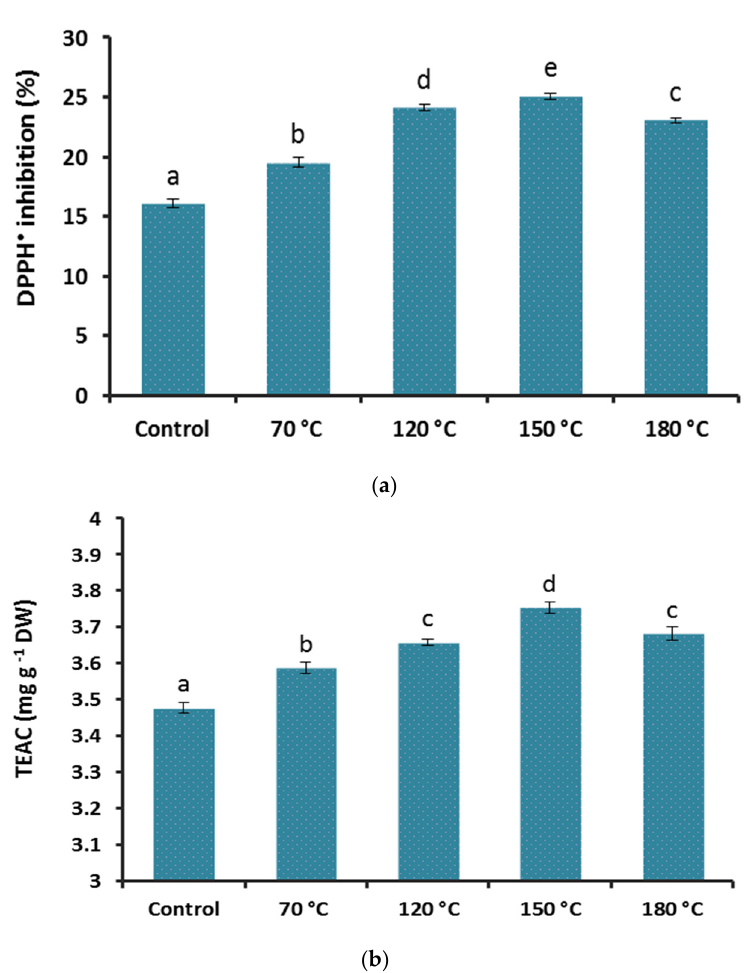
Figure 3. The antioxidant capacity (mean ± StDev) of ( G. lingzhi ) basidiocarp extract (2.5 mg mL − 1 ) after heat treatment in DPPH ( a ) and ABTS ( b ) assays. Different letters are for statistically different values (Tukey’s post hoc test, p < 0.05).